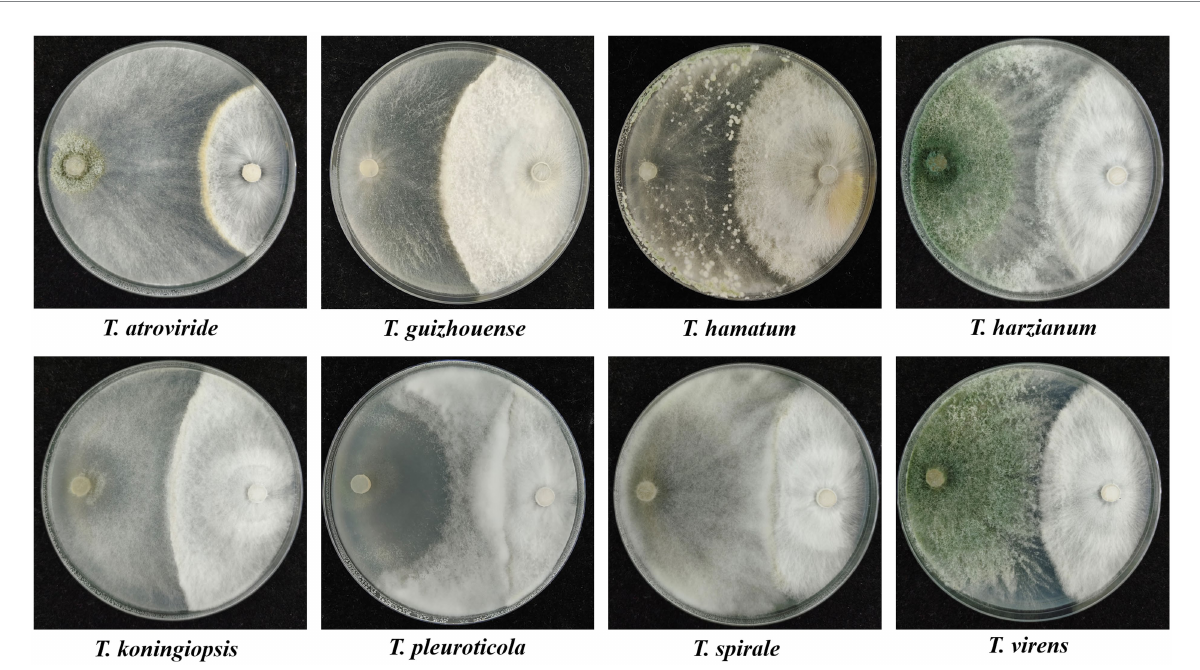
FIGURE 6 Dual cultures of the representative isolates of different Trichoderma species (left) against Ganoderma lucidum (right) on PDA plates for 6 days.